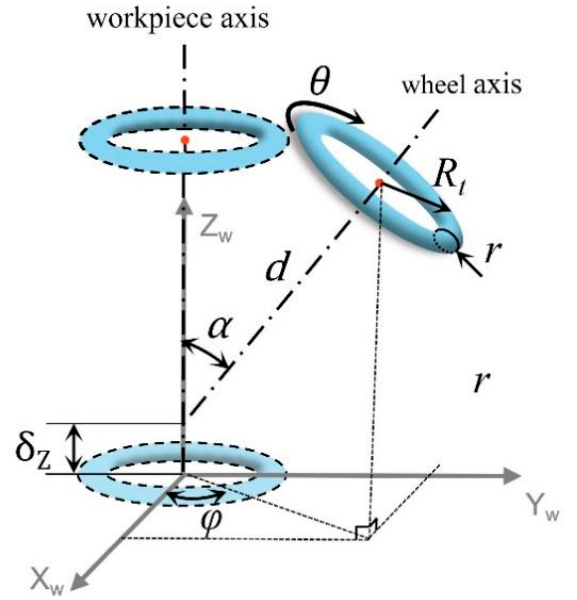
Figure 3. Schematic diagram of the torus.